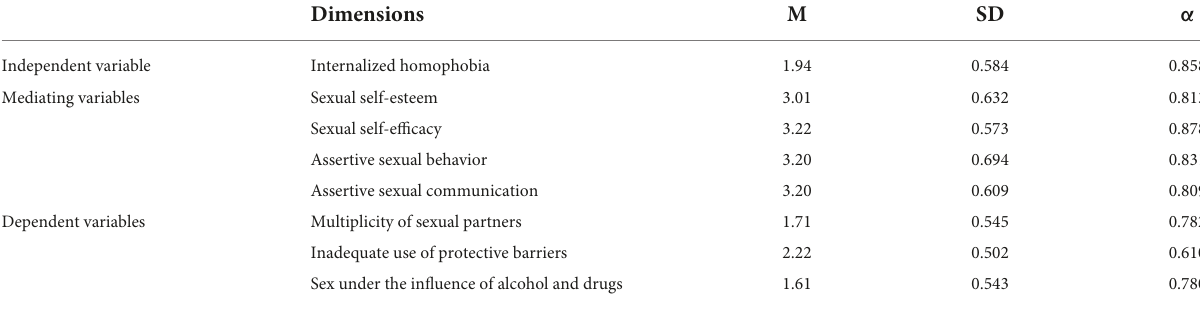
TABLE 1 Descriptive statistics for sample.